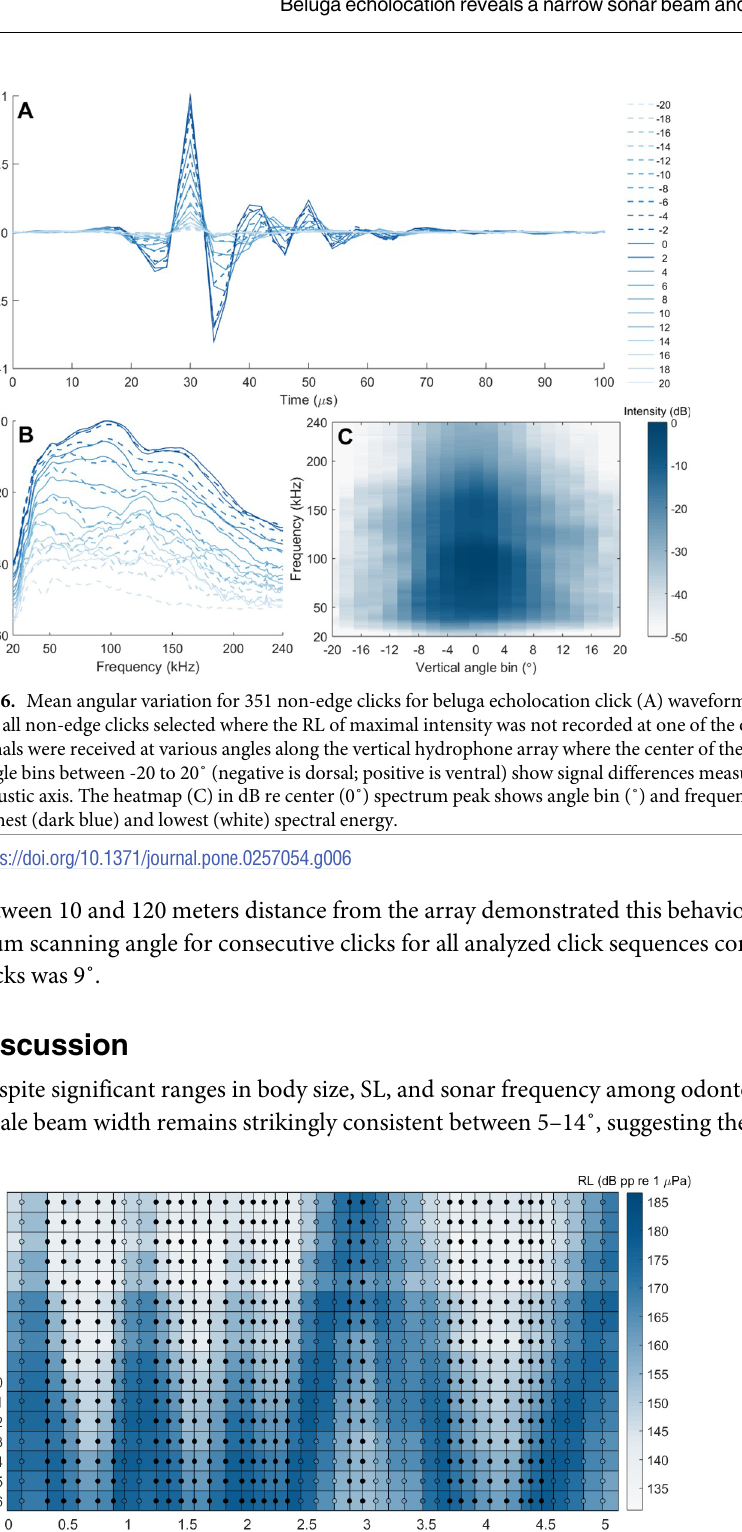
Fig 7. Vertical scanning of beluga sonar beam. Distribution of the received level (RL; represented via color spectrum) for each hydrophone for 41 clicks in 5 seconds, demonstrating vertical scanning of the array. Filled circles signify clicks where the hydrophone with the maximum RL was received by one of the outermost receivers and therefore was directed towards the edge of the array.